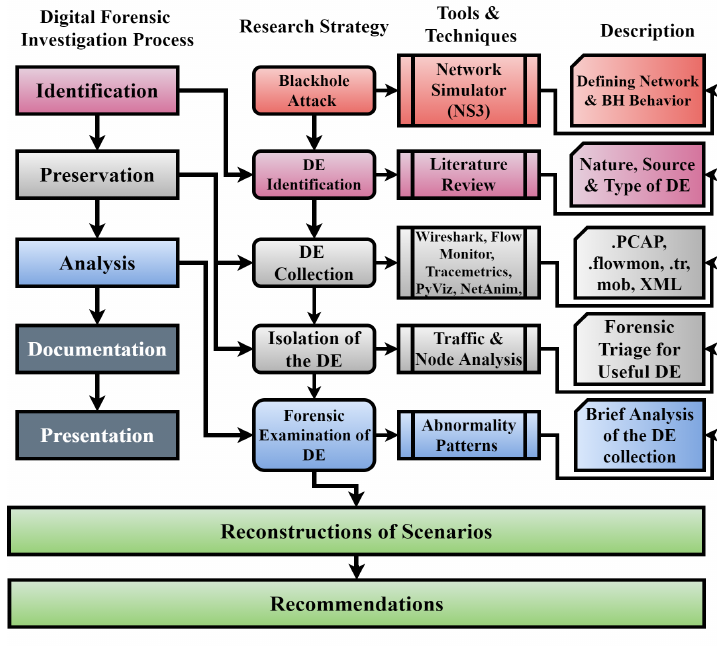
Figure 1. Strategy for forensic analysis of a BH